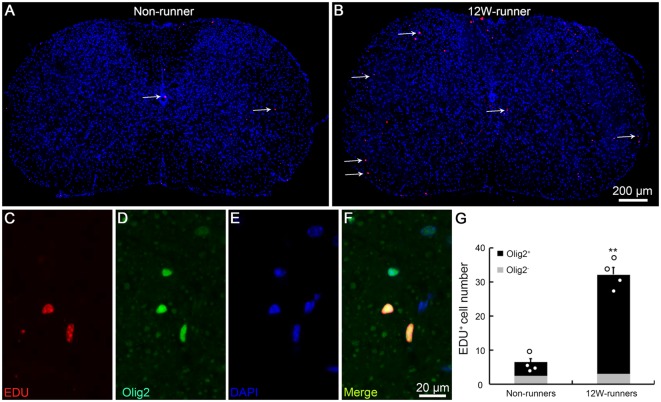
Exercise activates neurogenesis in the spinal cord. (A,B) Overview of 5-ethynyl-2′-deoxyuridine (EDU) signal in spinal cords in non-runners (A) and runners (B), and EDU-positive cells are indicated by arrows. (C–G) EDU-positive cells in runners are mostly Olig2-positive and about 4.8-fold more abundant in runners than in non-runners. Each circle represents the data from one animal. **P < 0.01; n = 4 in each group.